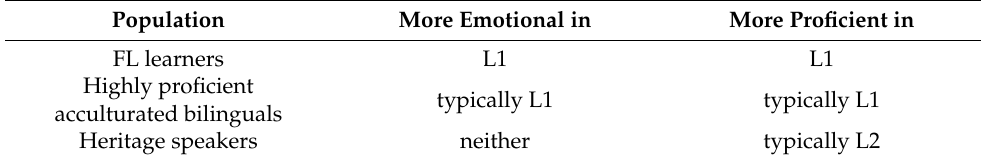
Table 1. Differences between bilingual populations. Population More Emotional in More Proficient in FL learners L1 L1 Highly proficient typically L1 typically L1 acculturated bilinguals Heritage